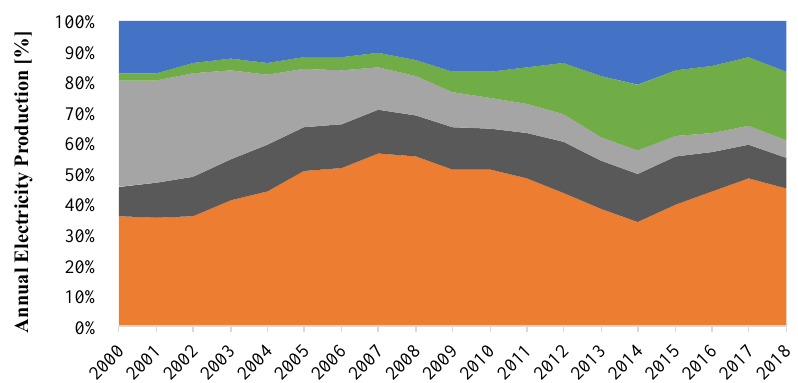
Figure 2. Electricity production share of each technology in Italy between 2000 and 2018 (author’s elaborations on Terna, Transparency Report Platform [2]).